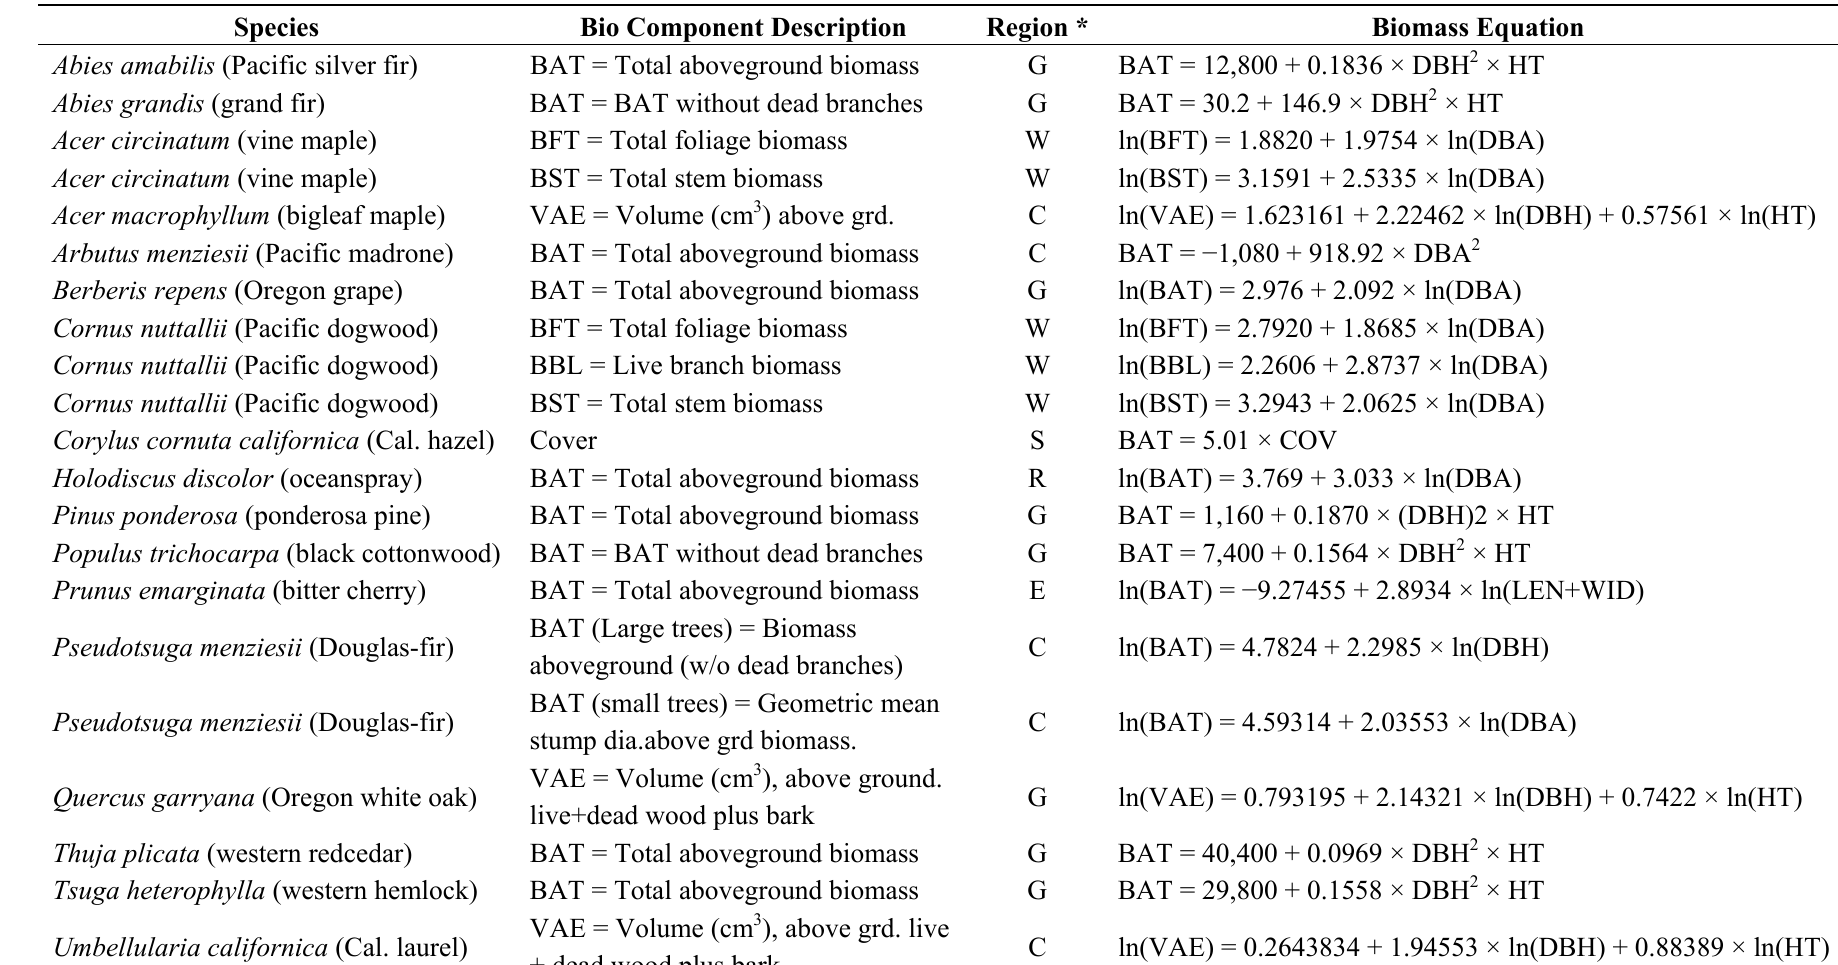
Table 4. Equations used to determine plot biomass from biomass computation package BIOPAK